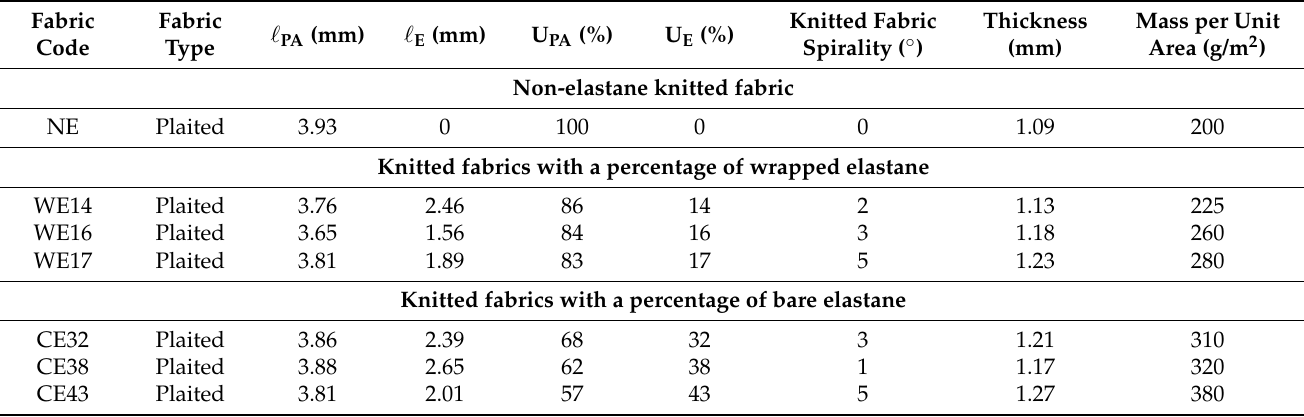
Table 2. Test results for plaited knitted fabric